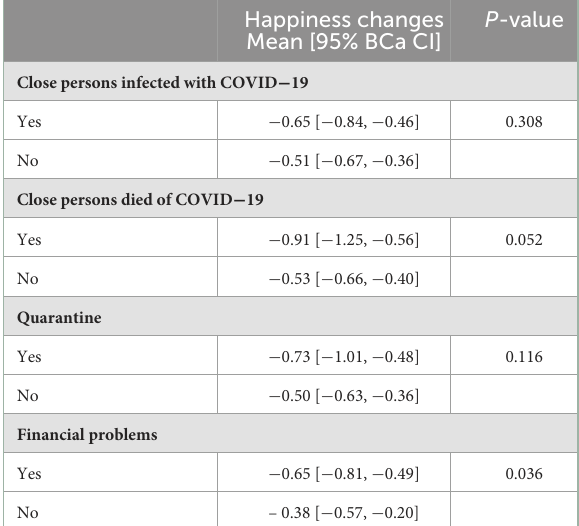
TABLE 3 Associations between participants’ characteristics and changes in perceived family